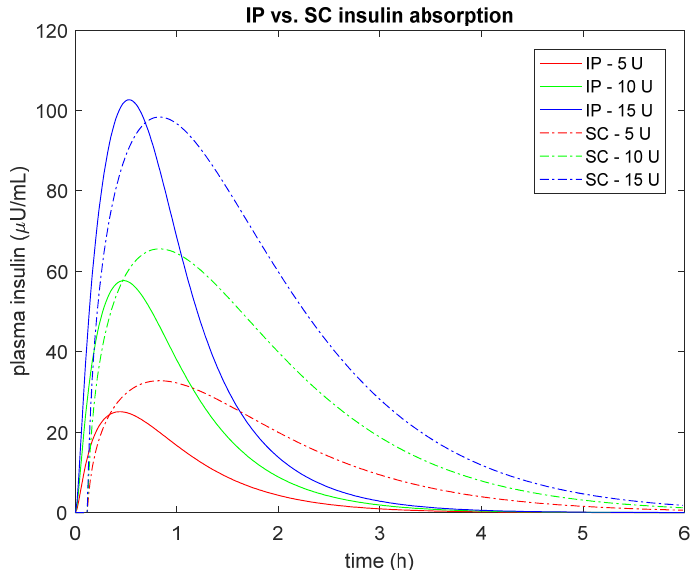
Figure 4. Simulated plasma insulin concentration after different bolus injection amounts (5U, red; 10U green and 15U blue) of U-400 regular insulin using the proposed IP model (continuous line) vs. U-100 fast-acting insulin concentration obtained with the SC model incorporated into the UVa/Padova T1D Simulator [15] (dashed line). Median estimated parameters were used to simulate both the IP and SC routes.